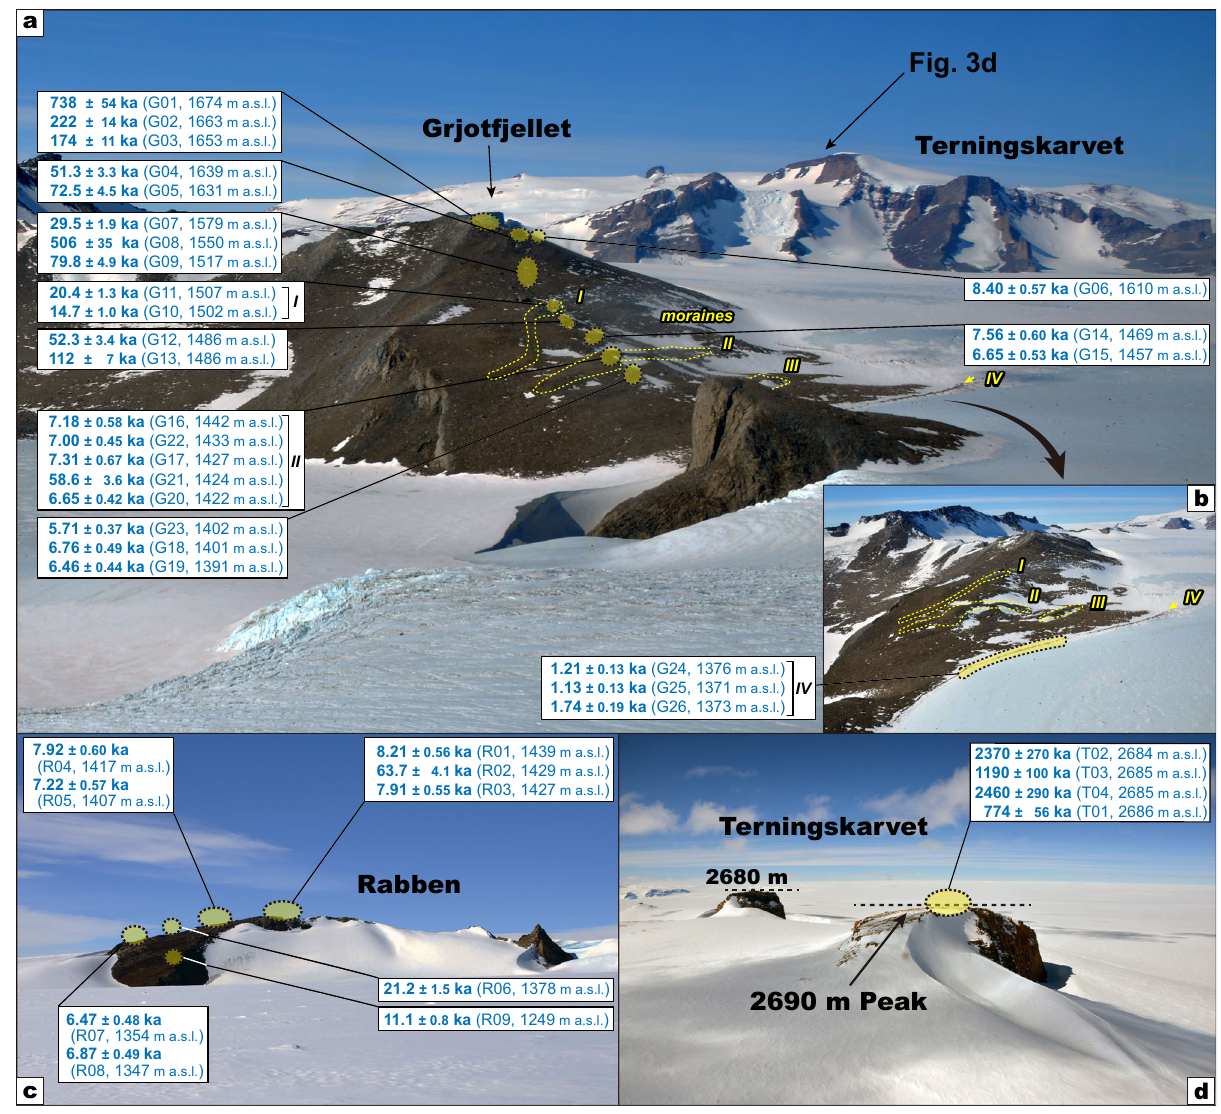
Fig. 3 Photographs of Grjotfjellet, Terningskarvet, and Rabben. Approximate sample site locations are shown by yellow circles along with 10 Be exposure ages. a Overview of Grjotfjellet, with Terningskarvet in the background. 10 Be exposure ages of erratic samples collected from three moraine ridges are labeled by their corresponding moraine numbers. b Sample locations on Grjotfjellet immediately adjacent to the contemporary ice sheet surface. Yellow dashed lines in a , b delineate well-de fi ned moraine ridges at Grjotfjellet, with Roman numerals indicating moraine numbers that correspond to those in Fig. 2a. c Overview of Rabben. The surface elevation of the ice sheet on the western side of Rabben (where the photograph was taken) is ~150 – 200 m lower than that on the opposite side. d The 2690 m a.s.l. summit of con fi dence interval) with an onset age of 8.6 ka (7.4 – 10.2 ka in a 95% con fi dence interval; Fig. 6b and Supplementary Fig. 1.4b).